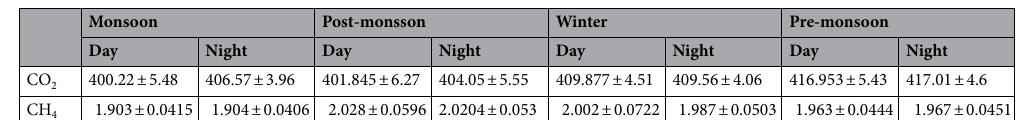
Table 1. Season wise average concentration and standard deviation of GHGs during day and night.